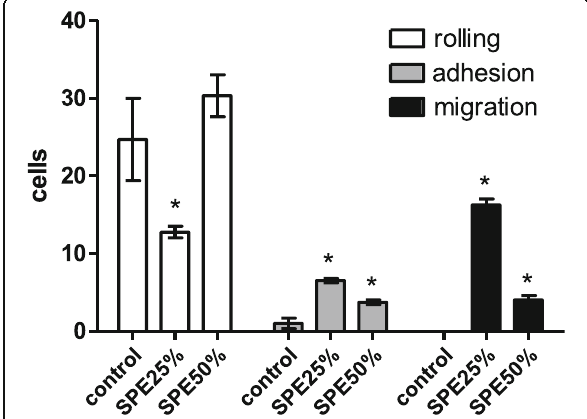
Fig. 1 Leukocyte count on the cremaster muscle microcirculation 2 h after 25 and 50% SPE fractions injection. * p <